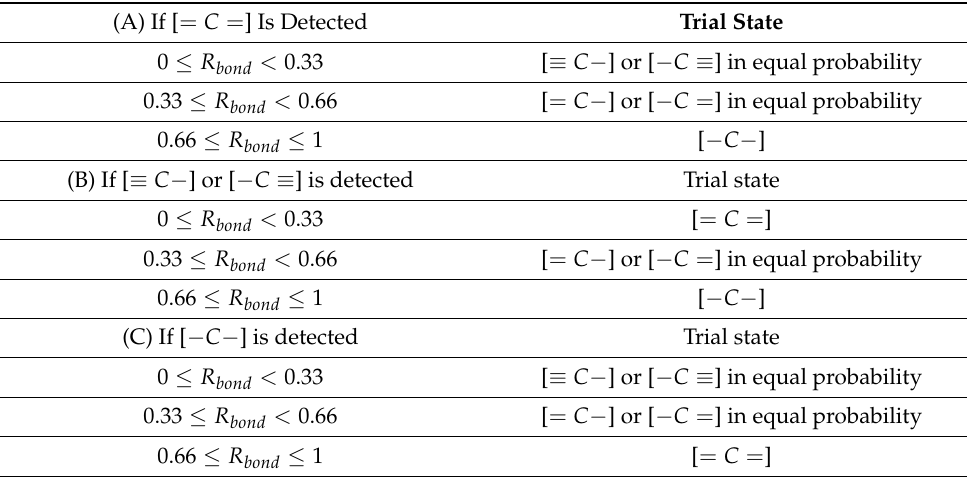
Table 1. The trial state of a covalent